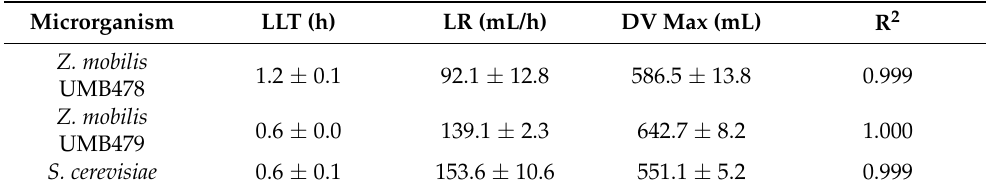
Table 4. Dough leavening properties (mean and standard deviation values of two technological replicates): lag leavening time (LLT, h), leavening rate (LR, mL/h) and maximum dough volume (DV max, mL) of dough samples leavened with the two Z. mobilis wild strains and baker’s yeast for comparison purposes.